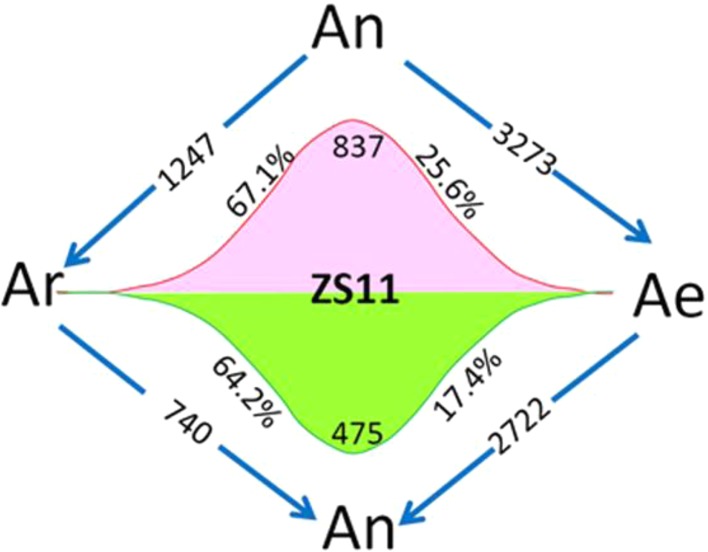
Diagram of the total number of genes specially up- and downregulated in the A subgenome of ZS11 (An) in comparison with RBR (Ae) and four natural B. rapa lines (Ar). The arrows indicate the genomes in which genes are down-regulated, and the numbers inside represent the number of downregulated genes. Red and green wavy lines indicate a continuous trend of gene expression from Ar to An and Ae. The numbers represent the numbers of genes with this expression trend, and the percentages represent the proportions of these genes in the total up- and downregulated genes in each pairwise comparison. Ar vs An represented DEGs shared by all B. rapa varieties versus An-subgenome of B. napus. Ar vs Ae represented DEGs shared by all four B. rapa versus RBR. An vs Ae represented DEGs between RBR and those in An-subgenome of B. napus ZS11.